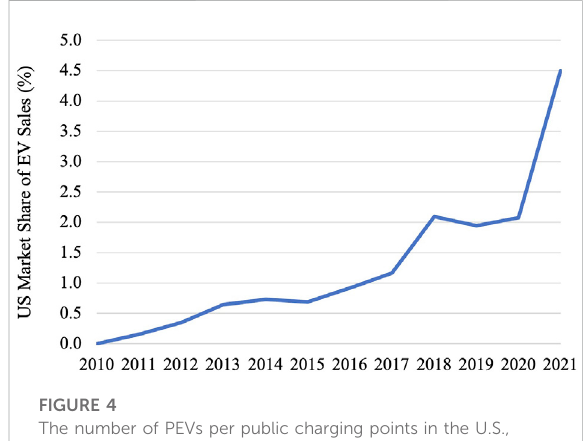
FIGURE 4 The number of PEVs per public charging points in the U.S., europe, and the world, 2021 (IEA,